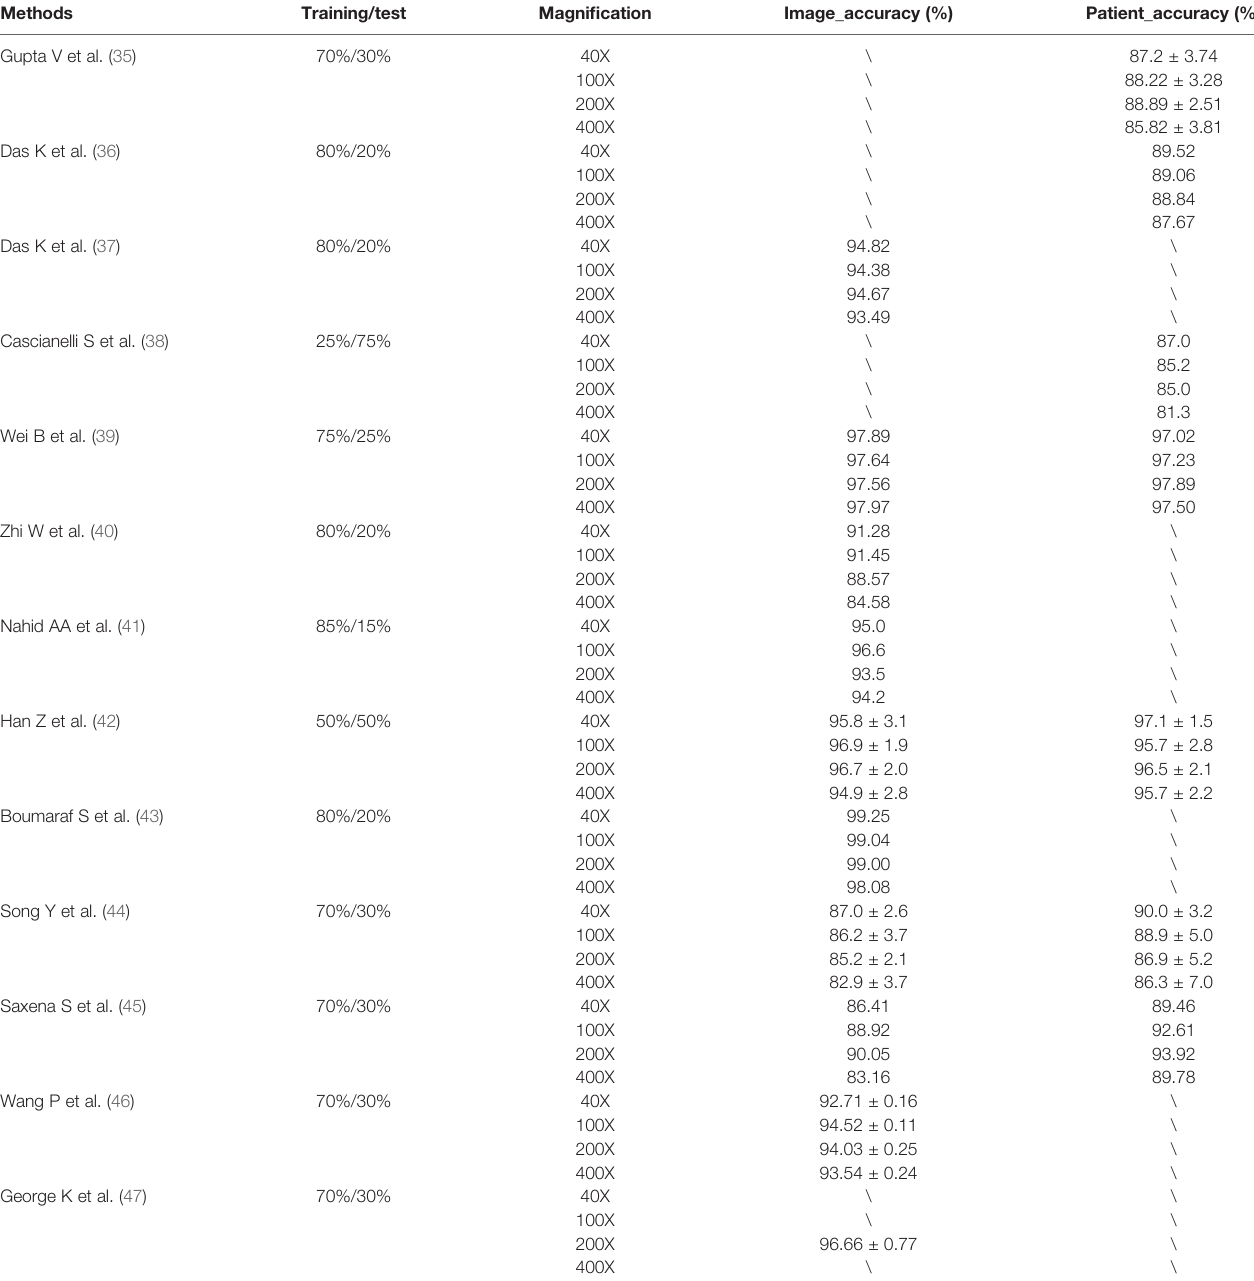
TABLE 8 | Comparison of the proposed methods with other state-of-the-art methods.